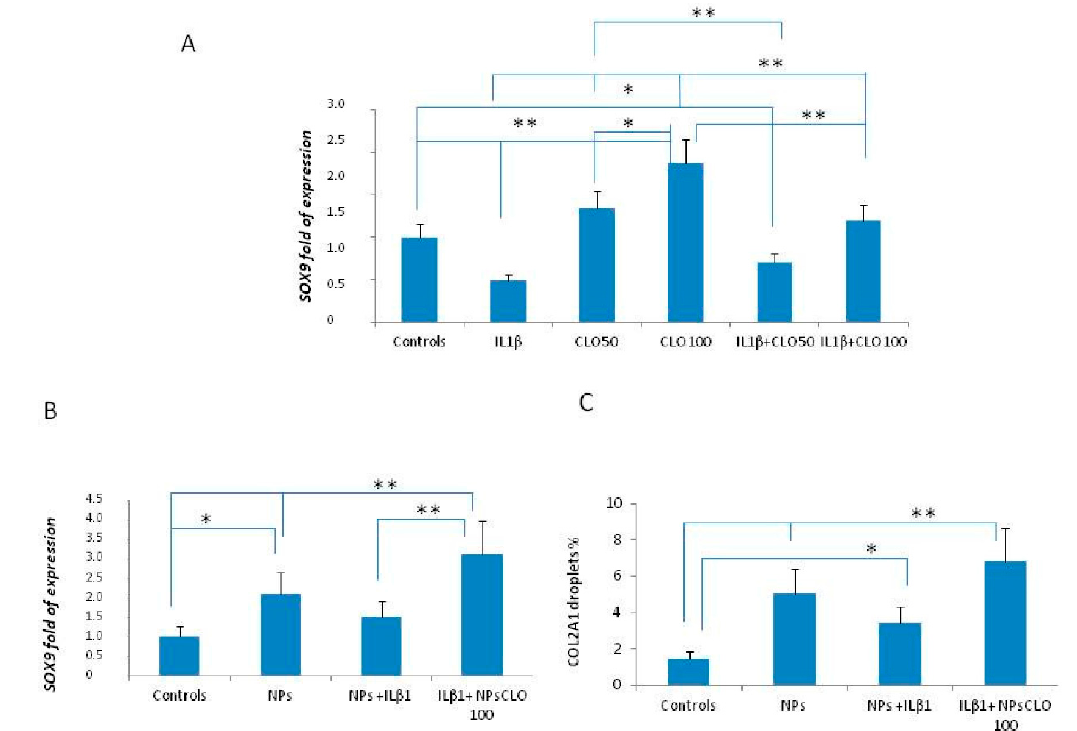
Figure 2. Effects of clodronate in mesenchymal stem cells (MSCs). SOX9 fold of expression in MSCs treated with and w/o clodronate in chondrogenic medium in the presence or absence of IL β 1 ( A ). SOX9 ( B ) and COL2A1 ( C ) fold of expression in chitosan and hyaluronic acid empty nano particles (NPs) or clodronate embedded nanoparticles in chindrogenic medium with or w/o IL β 1. The synergistic action of NPs and clodronate is noteworthy. * p < 0.05; ** p < 0.01.